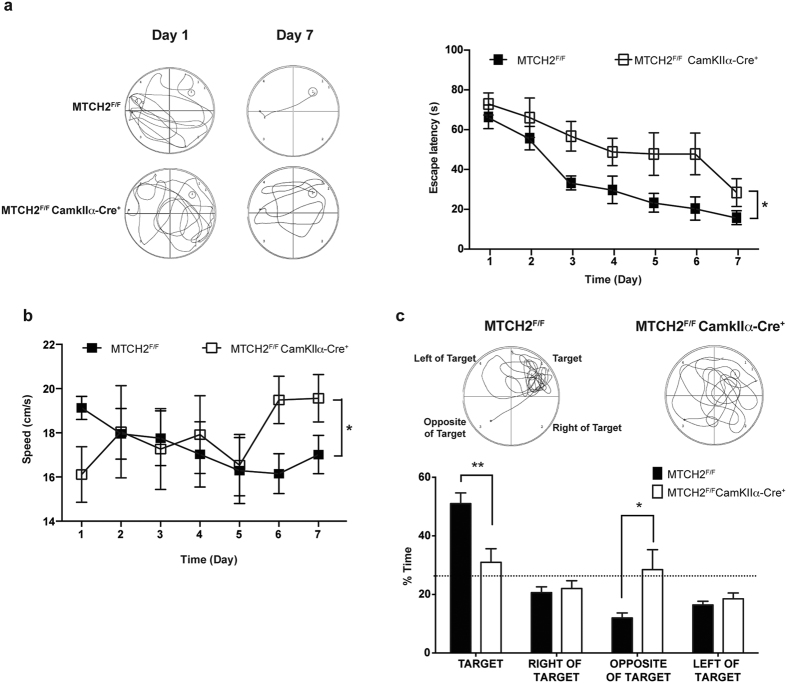
MTCH2F/FCamKIIα-Cre+ mice display a hippocampal-dependent cognitive deficit.(a) MTCH2F/F
CamKIIα-Cre+ mice display a learning deficit. Mice were subjected to 4 trials per day with an interval of 15 min, for 7 consecutive days (See Methods). Left panel: representative swimming paths. Right panel: Mean escape latency over time during training sessions in the water maze test. Results are presented as mean ± SEM (*p ≤ 0.05, n = 10–13 mice; two-factor with replication ANOVA was used for the statistical analysis). (b) MTCH2F/FCamKIIα-Cre+ mice show increased swimming speed. Results are presented as mean ± SEM (*p ≤ 0.05, n = 10–13 mice; two-factor with replication ANOVA). (c) MTCH2F/FCamKIIα-Cre+ mice show a spatial memory deficit. Spatial memory was evaluated using a probe test in the Morris Water Maze expressed as percentage of time spent in different zones (bottom panel) and representative swimming paths (top panel). Results are presented as mean ± SEM (*p < 0.05, **p < 0.01; n = 10–13 mice; two-tailed, unpaired, unequal variance t-test).